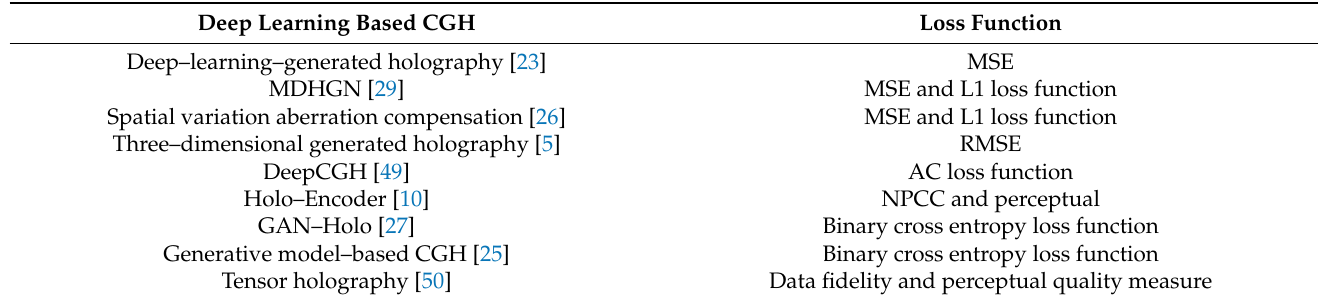
Table 3. The loss functions for deep–learning–based